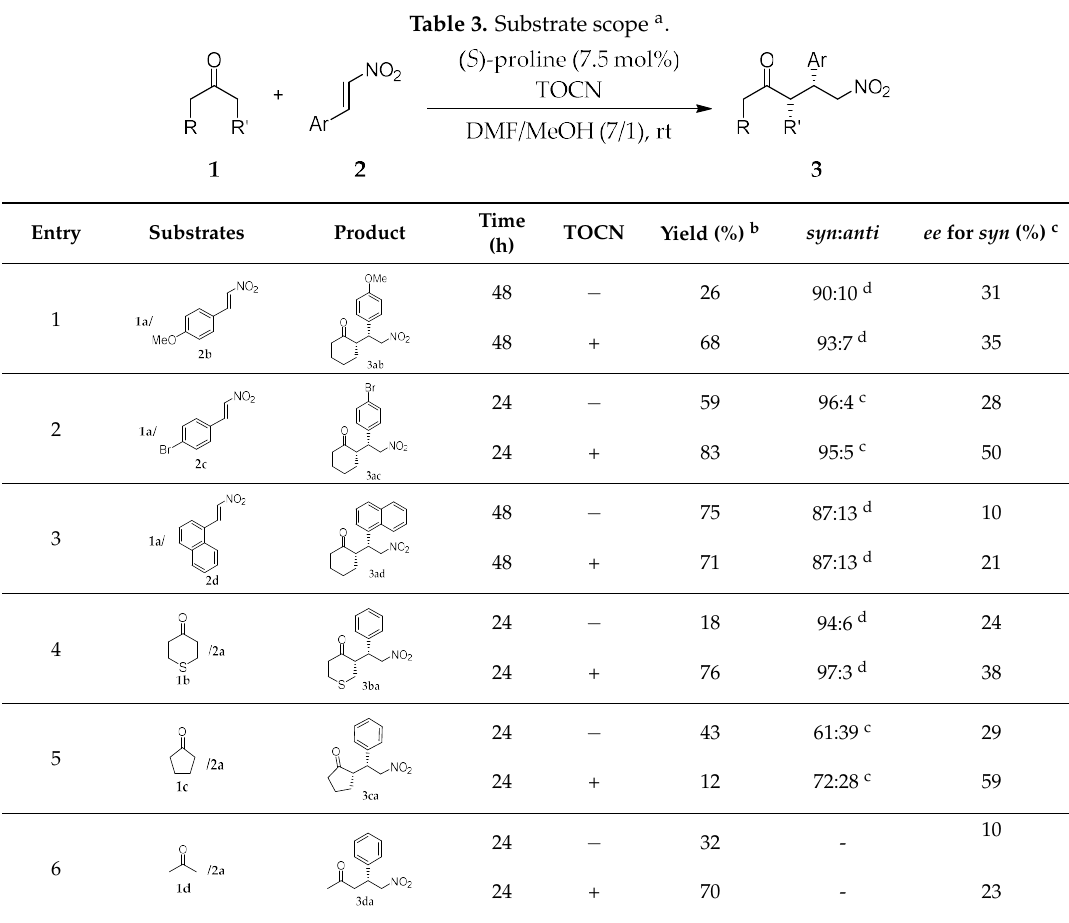
Table 3. Substrate scope a .